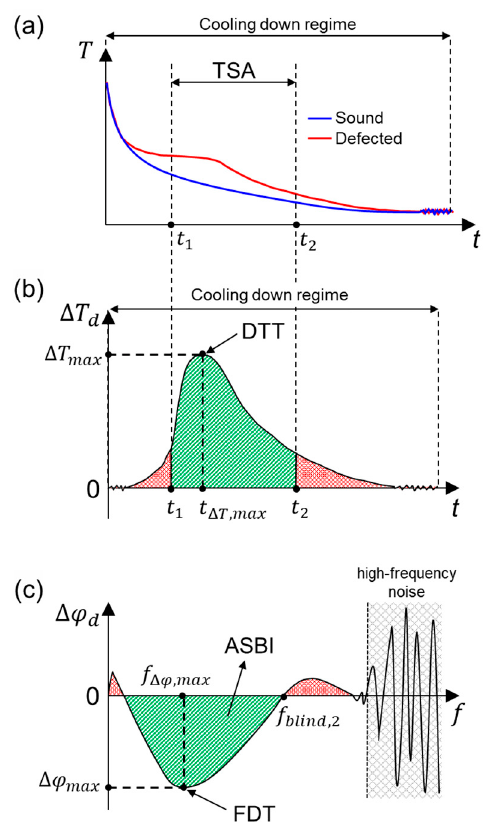
Figure 4. Graphical representation of the considered analysis techniques in the ( a , b ) time domain (i.e., dynamic thermal tomography (DTT) and thermal signal area (TSA)) and ( c ) frequency domain (i.e., frequency-domain tomography (FDT) and adaptive spectral band integration (ASBI)).